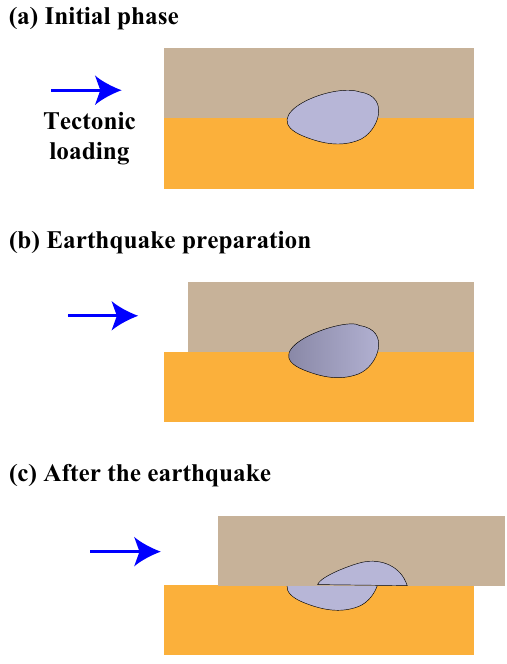
Figure 5. The cartoon illustrates the mechanism of preparation and generation of large